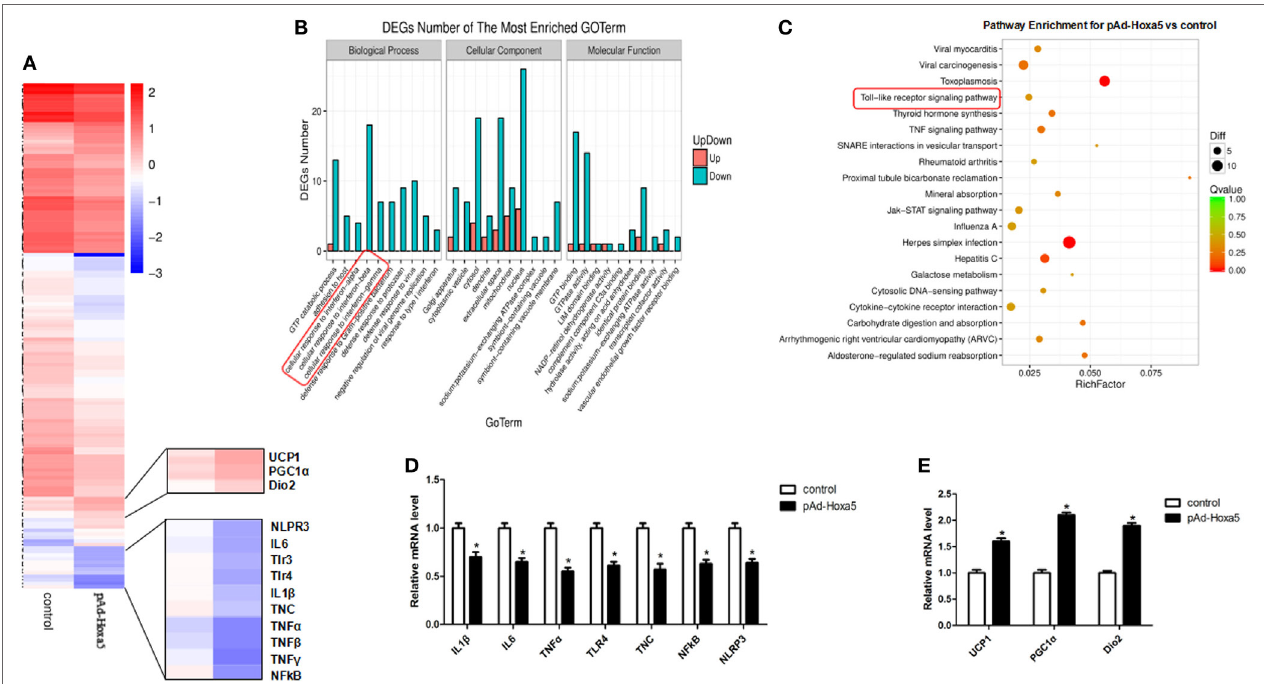
FigUre 1 | Overexpression homeobox a5 (Hoxa5) downregulated inflammation genes and upregulated thermogenic genes in adipocytes. (a) Heatmap of genes set from RNA-seq data with forced expression of Hoxa5 in mice adipocytes, along with the top affected genes ( n = 3). (B) Gene ontology (GO) analysis of the altered genes in (a) ( n = 3). (c) Analysis of altered pathway enrichment in response to forced expression of Hoxa5 ( n = 3). (D,e) Changes in the mRNA level of genes associated with inflammation and browning, which were significantly altered from RNA-seq analysis ( n = 3). Values are represented as means ± SEM. * p < 0.05 compared with the control